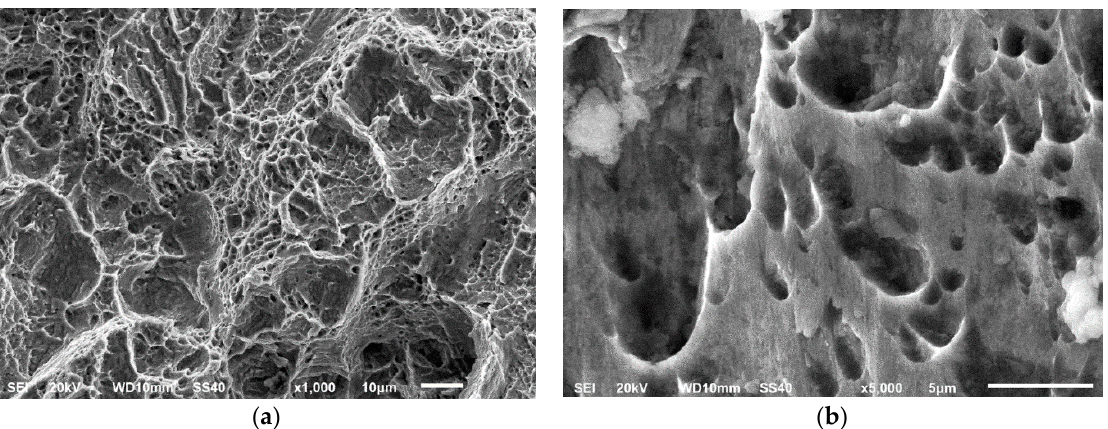
Figure 14. Surface fracture of the SMS alloy exhibiting ductile fracture after tensile test. A detail of the central region ( a ) and the shear lip ( b ).